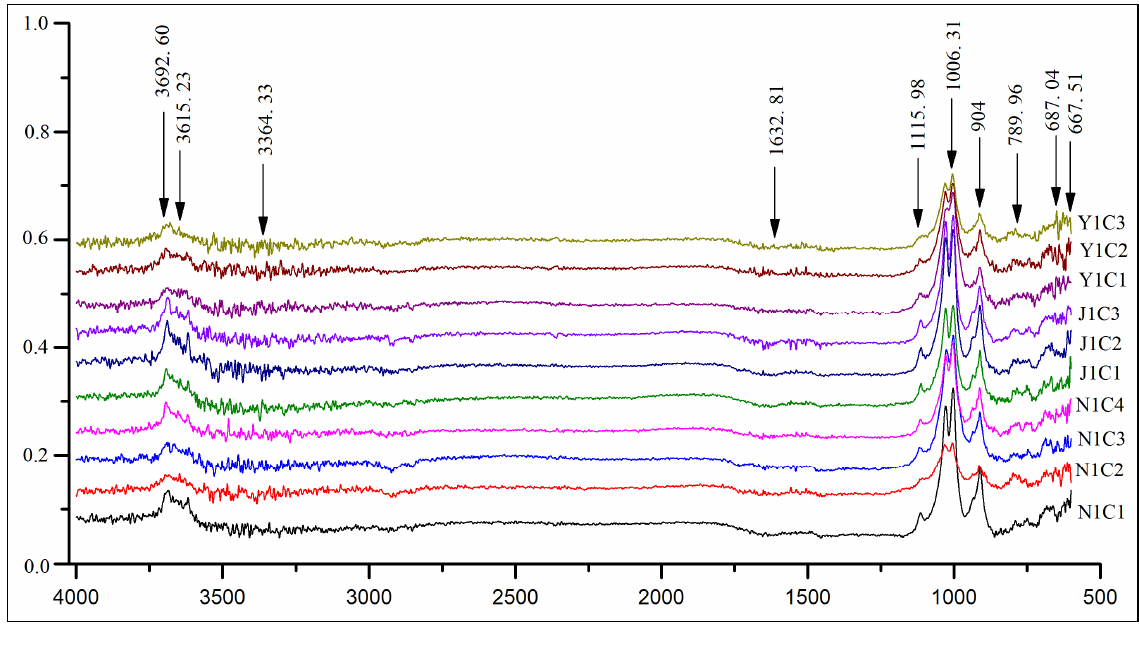
Figure 6. IR curves of the samples of the eastern part of the Douala sub-basin.